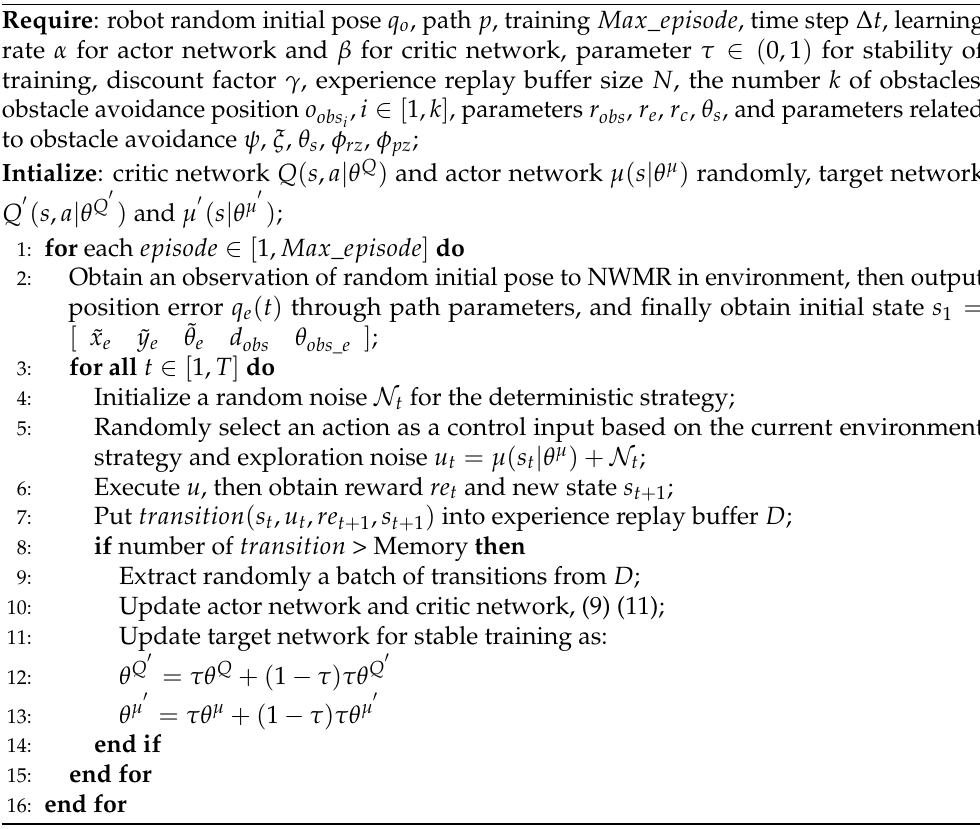
Algorithm 1 Path-Following and Obstacle Avoidance Control Strategy for